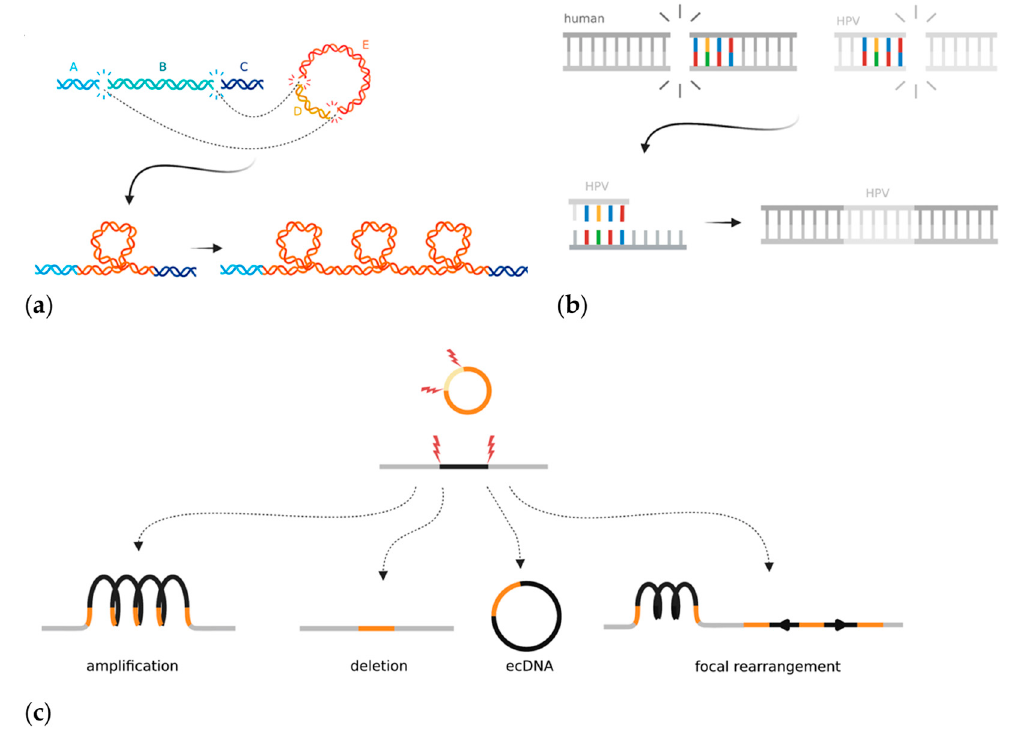
Figure 4. Mechanisms and local consequences of HPV integration in cancer: ( a ) The looping model proposes that HPV acts as a bridge between two pieces of non-contiguous DNA that have double-stranded DNA breaks in the human genome. The looped bridge can then be successively amplified upon DNA replication; ( b ) The microhomology model proposes that regions of microhomology between the human genome and HPV mediate integration through DNA repair mistakes in the fork stalling and template switching and microhomology-mediated break-induced replication pathways; ( c ) The integrated HPV genome can induce types of local rearrangements at the site of integration. Created with BioRender.com.